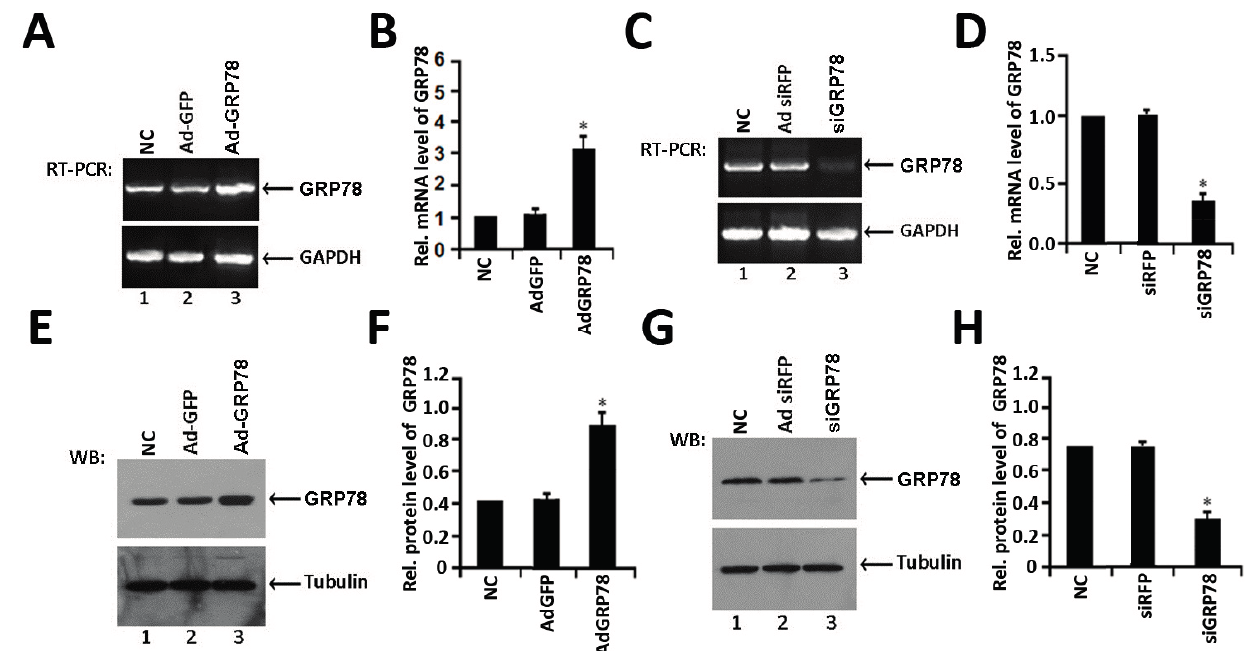
Figure 1. Expression of GRP78 in C3H10T1/2 cells after infected with Ad-GRP78 or Ad-siGRP78. ( A) . Analysis of GRP78 mRNA level with RT-PCR. Lane 1 : NC; lane 2 : Ad-GFP control; lane 3 : Ad-GRP78. C3H10T1/2 cells infected with Ad-GRP78 and control Ad-GFP, NC group were cultured for 48 h and GRP78 mRNA expression was determined by real-time PCR; ( B ). Quantification of relative levels of GRP78 in C3H10T1/2 cells. The normalized values were then calibrated against the control value, data were expressed as means ± S.D. ( n = 3). The left bar indicates a relative level of GRP78 mRNA of 1; * p < 0.05; ( C ) Analysis of GRP78 mRNA level with RT-PCR. Lane 1 : NC; lane 2 : Ad-siRFP control; lane 3 : Ad-siGRP78. C3H10T1/2 cells infected with Ad-siGRP78 and control Ad-siRFP, NC group were cultured for 48 h and GRP78 mRNA expression was determined by RT-PCR; ( D ) Quantification of relative levels of GRP78 in C3H10T1/2 cells. The normalized values were then calibrated against the control values, data were expressed as means ± S.D. ( n = 3). The left bar indicates a relative level of GRP78 mRNA of 1; * p < 0.05; ( E ) Determination of GRP78 protein expression level after infected with Ad-GRP78. Lane 1 : NC; lane 2 : Ad-GFP control group; lane 3 : Ad-GRP78 group. Proteins were separated by 10% SDS-PAGE and analyzed with anti-GRP78 antibody. Tubulin was used as internal control in Western blot. The levels of GRP78 proteins were obviously increased after infected with Ad-GRP78 compared with the control groups; ( F ) Semiquantification of relative levels of GRP78 in C3H10T1/2 cells. Levels were normalized against those of Tubulin by MJ Opticon Monitor Analysis Software (Bio-Rad, Hercules, CA, USA), data were expressed as means ± S.D. ( n = 3). Every treatment group was compared with control groups respectively, * p < 0.05. Error bars, S.D.; ( G ) Determination of GRP78 protein expression level after infected with Ad-siGRP78. Lane 1 : NC; lane 2 : adenovirus si-GRP78 control group Ad-RFP; lane 3 : Ad-siGRP78 group. Proteins were separated by 10% SDS-PAGE and analyzed with anti-GRP78 antibody. Tubulin was used as internal control in Western blot. The levels